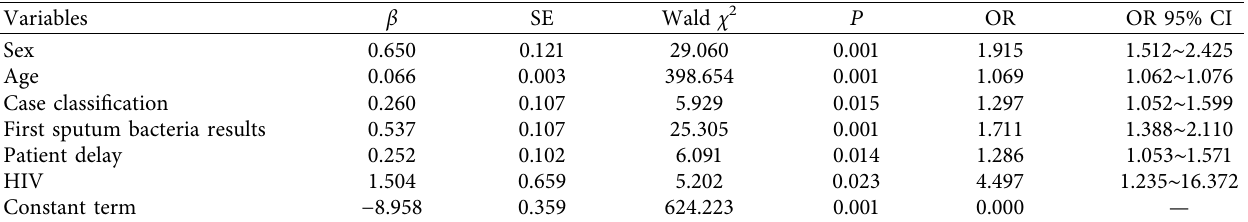
Table 3: Te multivariable unconditional logistic regression analysis of risk factors of mortality among pulmonary tuberculosis patients under the DOTS strategy.